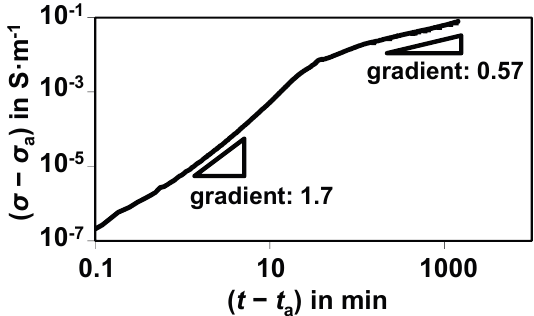
Figure 3. Electrical response (conductivity change σ − σ a ) during sulfidation of a single nickel catalyst pellet at 300 °C with 500 ppm H 2 S in N 2